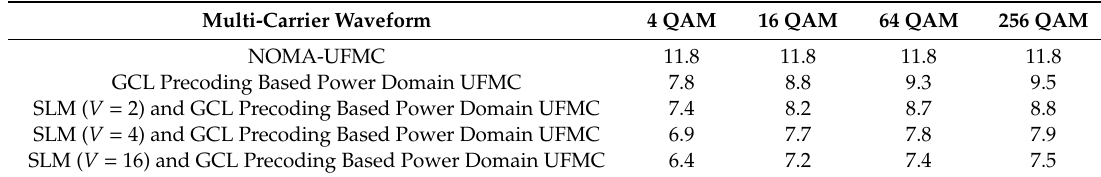
Table 2. Comparisons of the PAPR in dBs at 10 −3 clip rate.